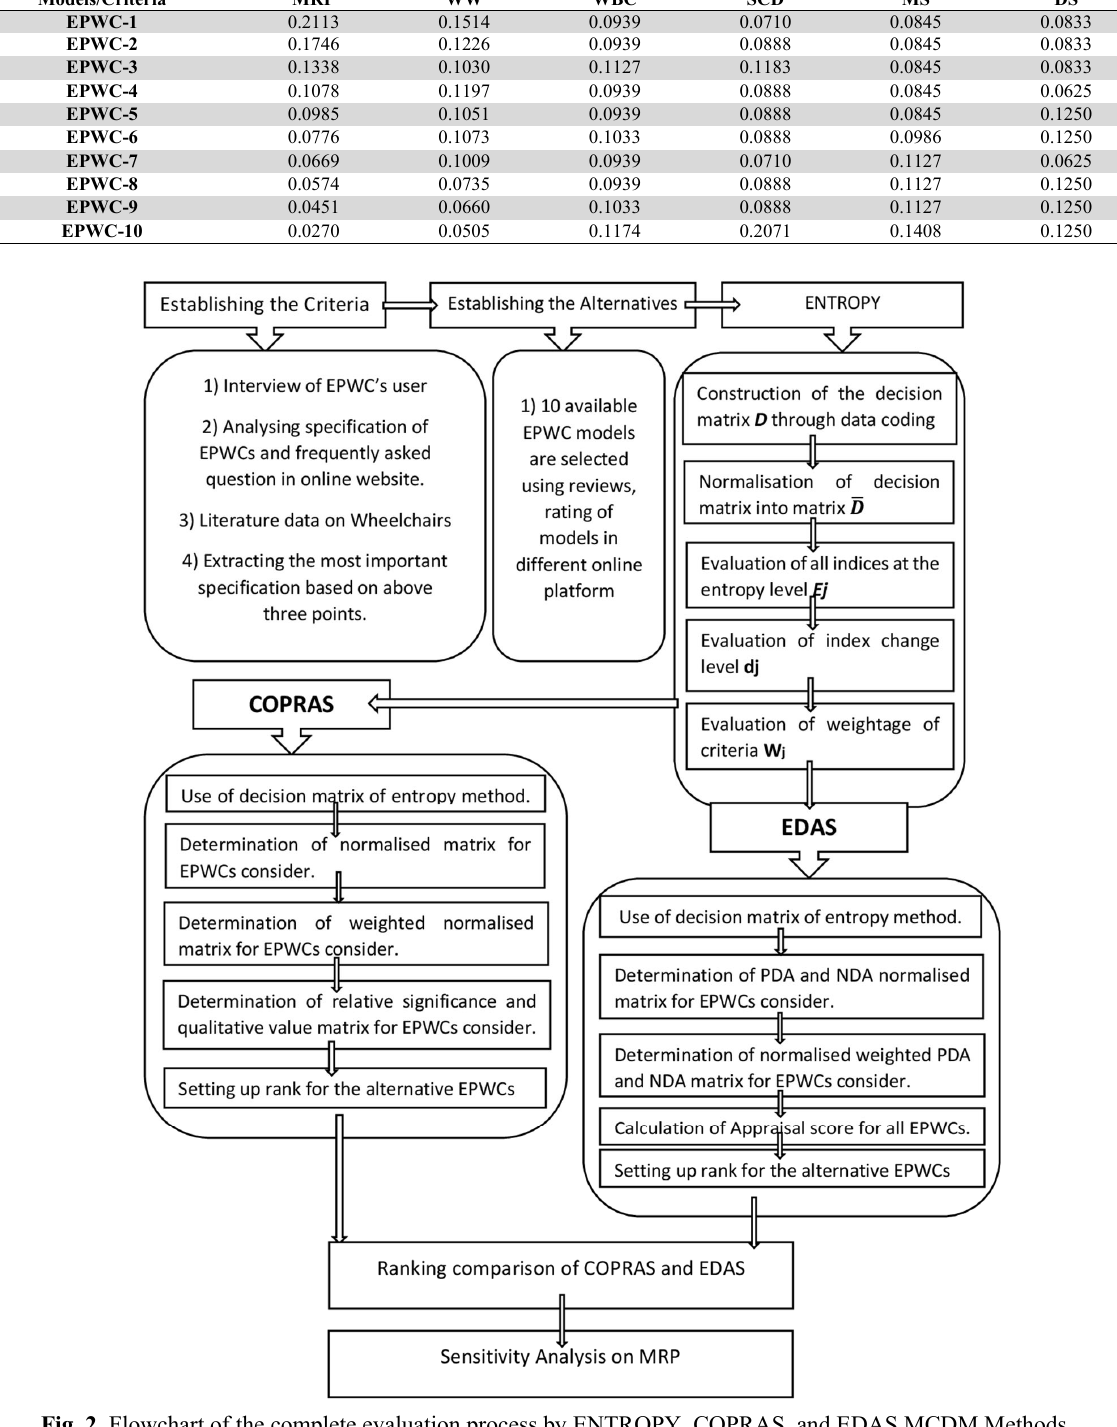
Final Normalized decision matrix 𝐃(cid:3365) for EPWC selection Models/Criteria